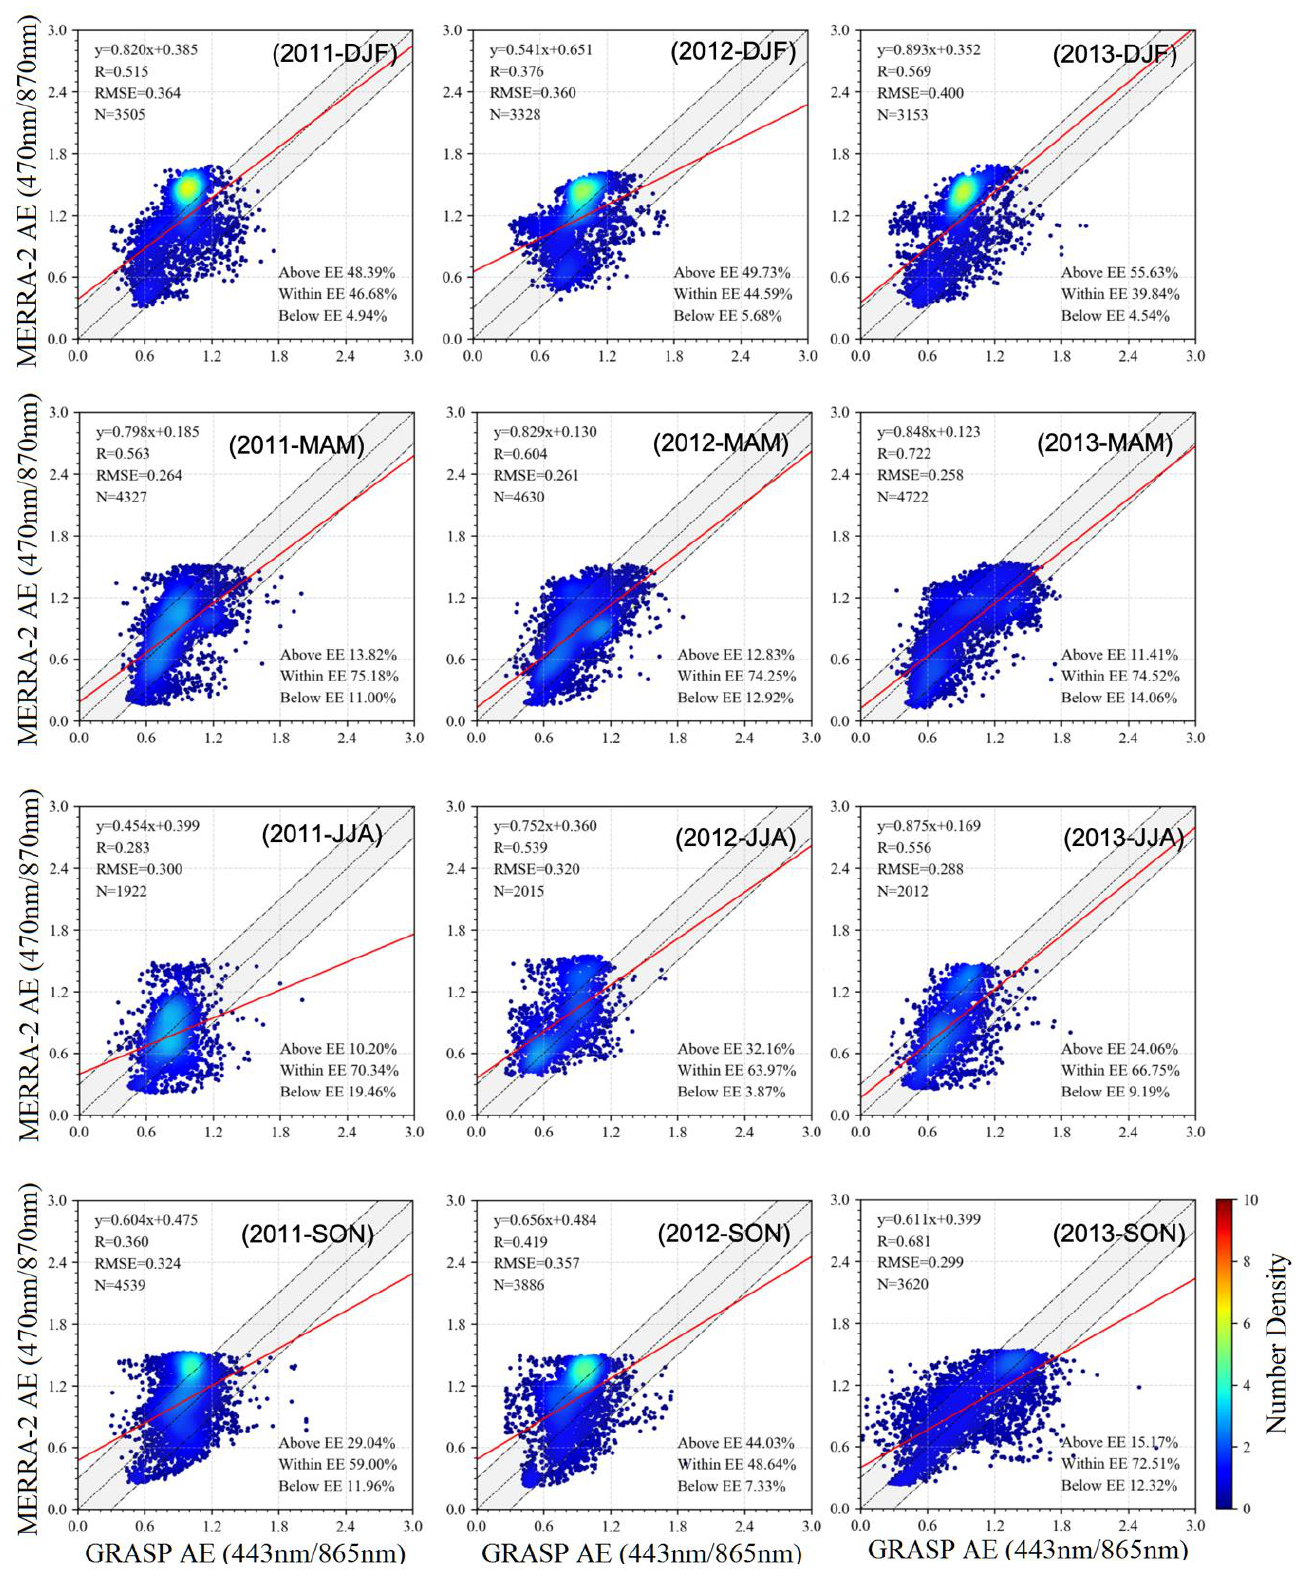
Figure 10. Same as Figure.6, but for AE.